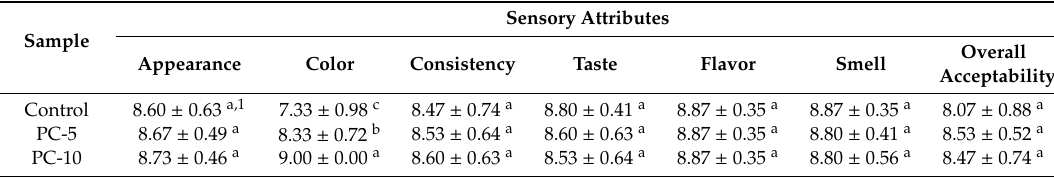
Table 5. Sensory scores (9-point Hedonic Scale) for the pastry cream enriched with MBC (Control—0% MBC; PC-5—5% MBC; PC-10—10%